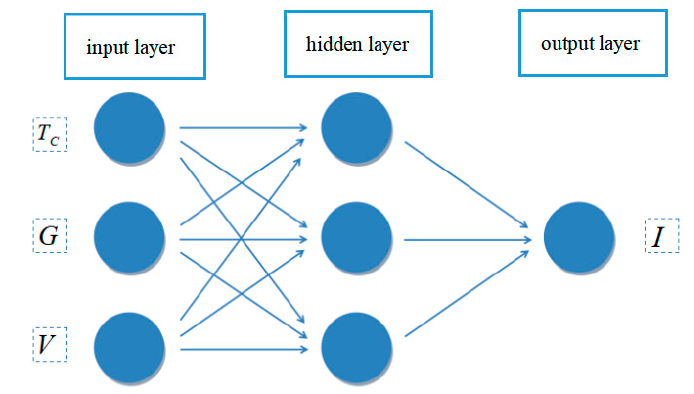
Figure 3. MLP structure of the neural network.